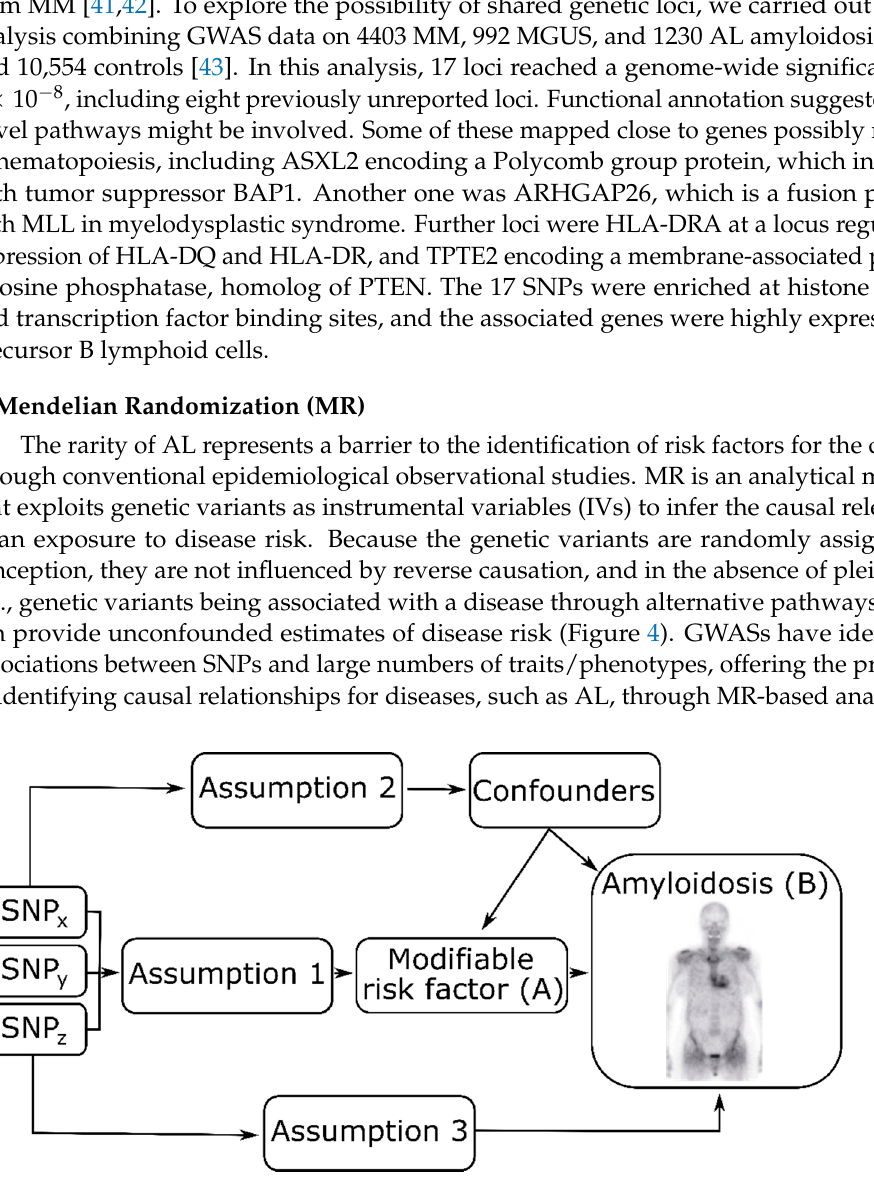
Figure 4. Principles of Mendelian randomization analyses and assumptions that need to be satisfied for unbiased analyses. Assumption 1 indicates genetic variants used as instrumental variables (i.e., SNPs) are only associated with the modifiable risk factor. Assumption 2 indicates genetic variants are not associated with any measured or unmeasured confounders. Assumption 3 indicates genetic variants only influence the risk of developing AL amyloidosis through the modifiable risk factor.